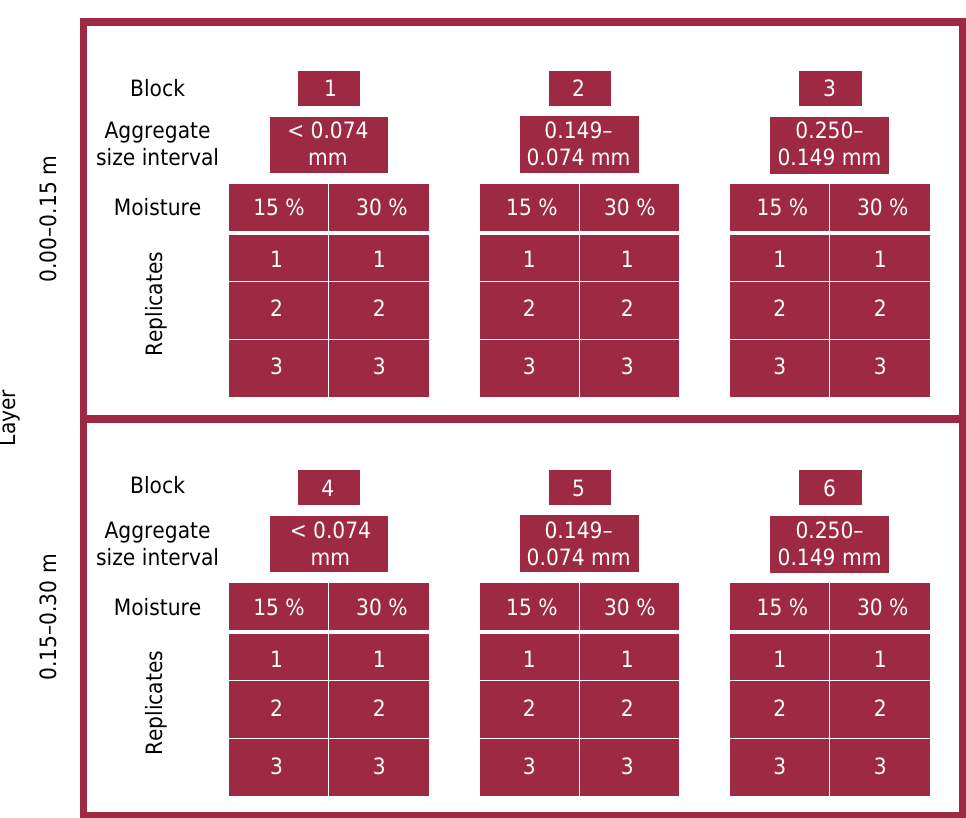
Figure 2. Generalized random block experimental design for soil incubation with two gravimetric moisture levels.